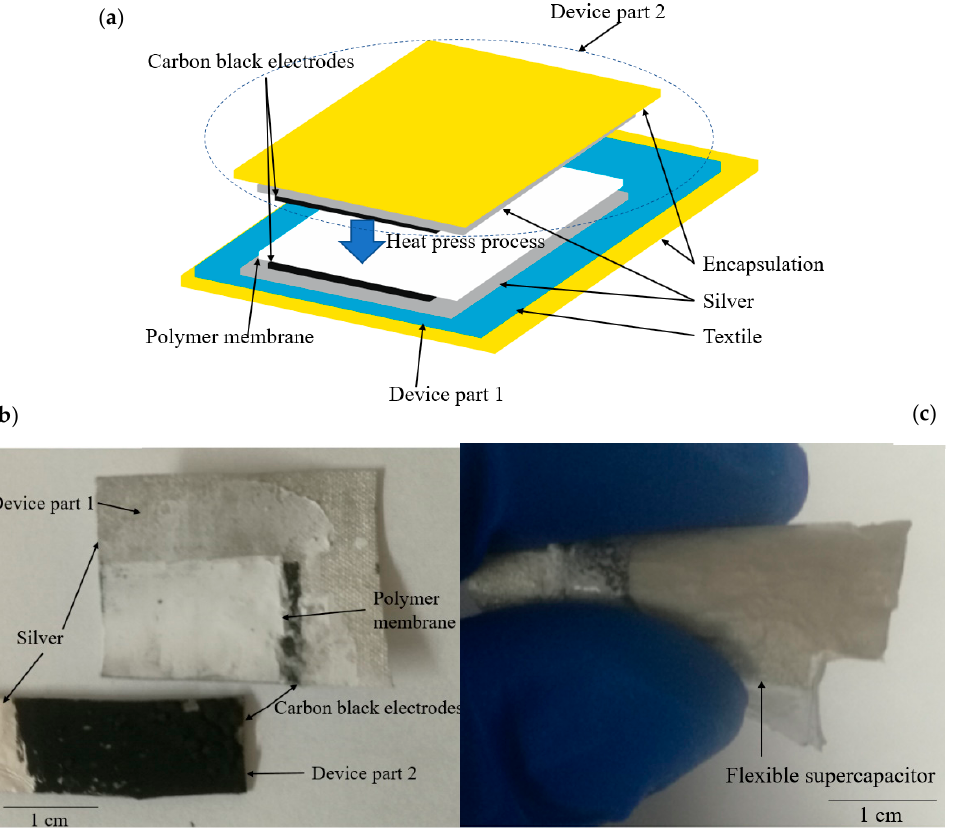
Figure 1. ( a ) Supercapacitor device schematic, ( b ) device part 1 and part 2, ( c ) flexible supercapaci- tor under 180 degrees of bending condition.